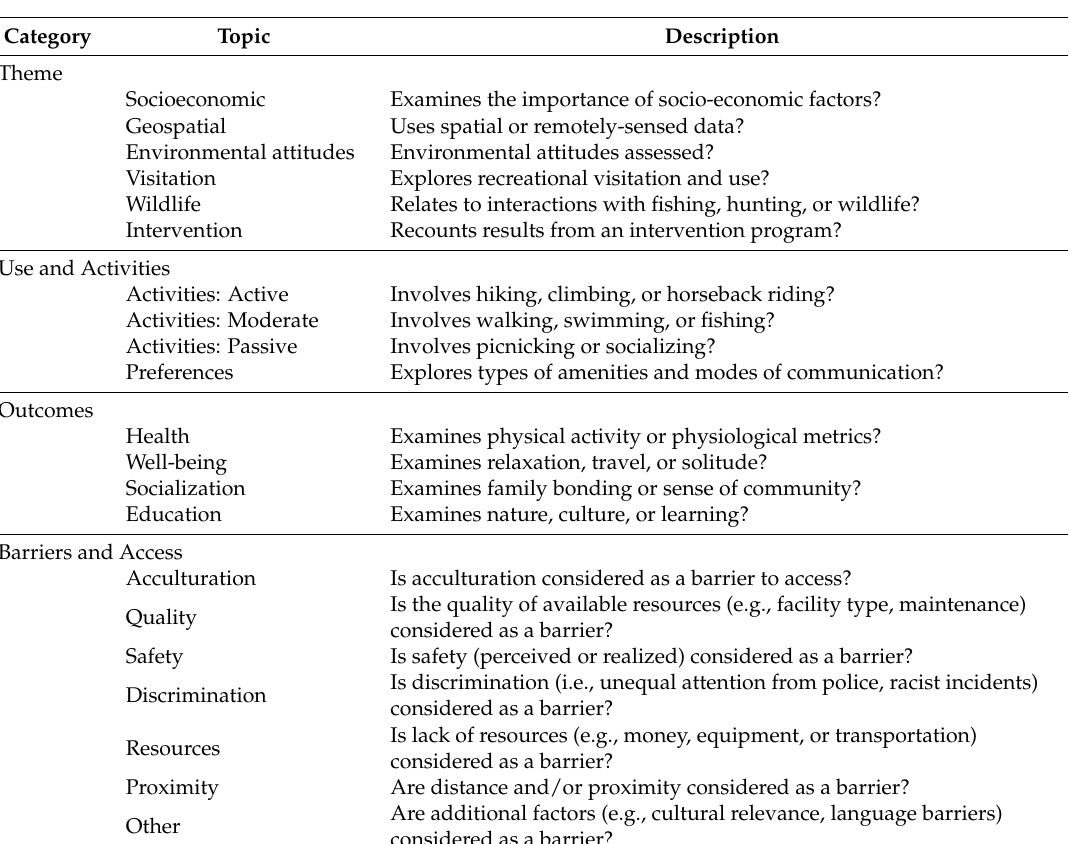
Table 1. Twenty-one research topics (across four broad categories) used to classify individual studies (yes or